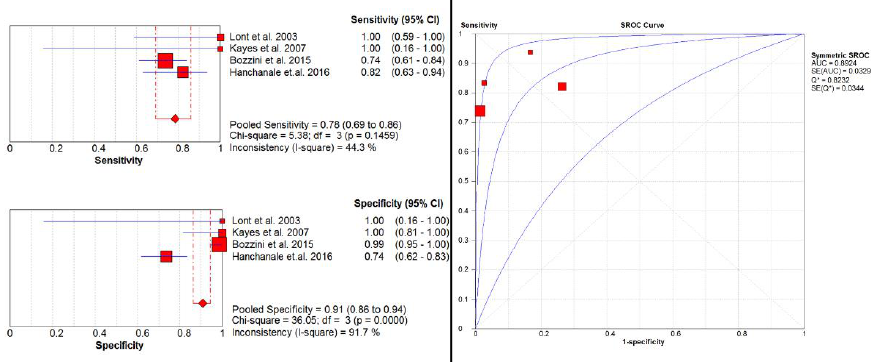
Figure 2. Pooled sensitivity, specificity, and SROC curve of MRI in detecting invasion of TA.